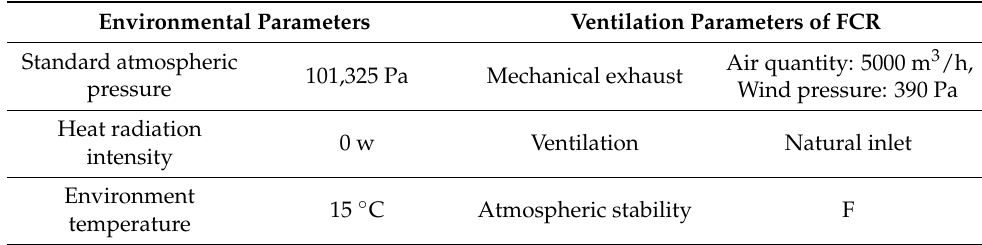
Table 3. Environmental parameters and ventilation parameters of fuel cell room.